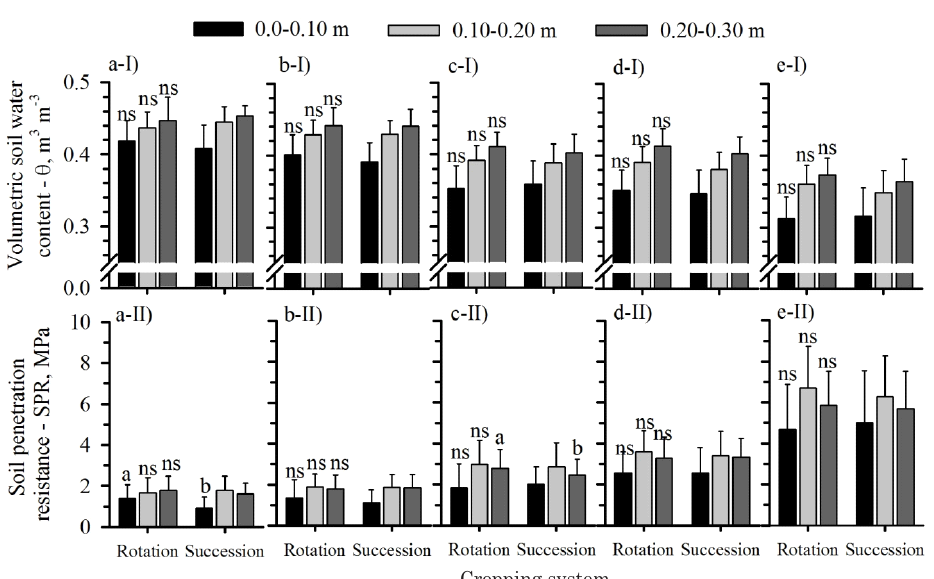
Figure 1. Volumetric soil water content (I) and soil penetration resistance (II) as function of cropping systems, determined at matrix potential of -6 kPa (a), -10 kPa (b), -33 kPa (c), -100 kPa (d) and -500 kPa (e). ns Not significant by the F-test (p<0.05). Means followed by the same letter in the same layer do not differ by the Tukey test (p<0.05). Vertical bars indicate standard deviation from the